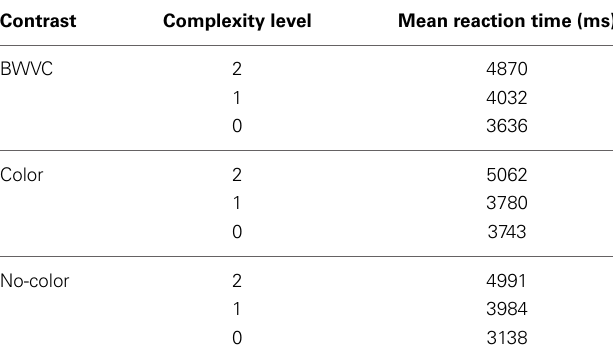
Table 1 | Descriptive statistics for category specific performance—Black-White Visual Contrast (BWVC), Color (C), and No-Color (NC) at 0, 1, and 2 levels of Relational